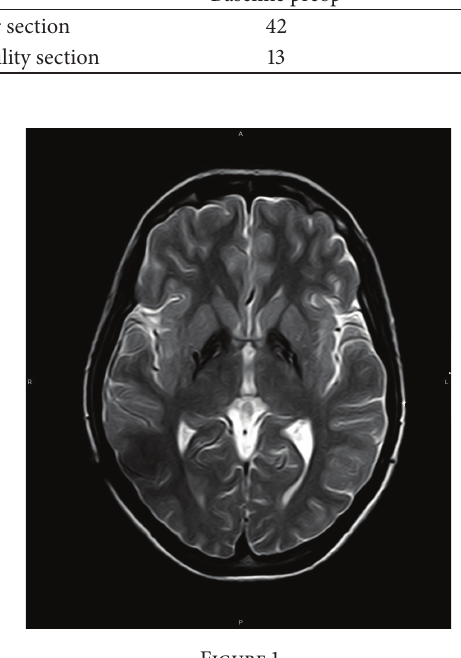
(ii) left channel: pulse width 60 𝜇 s; rate of 130 Hz, ampli- tude 3.2 V, case (+), and contact 4 ( −